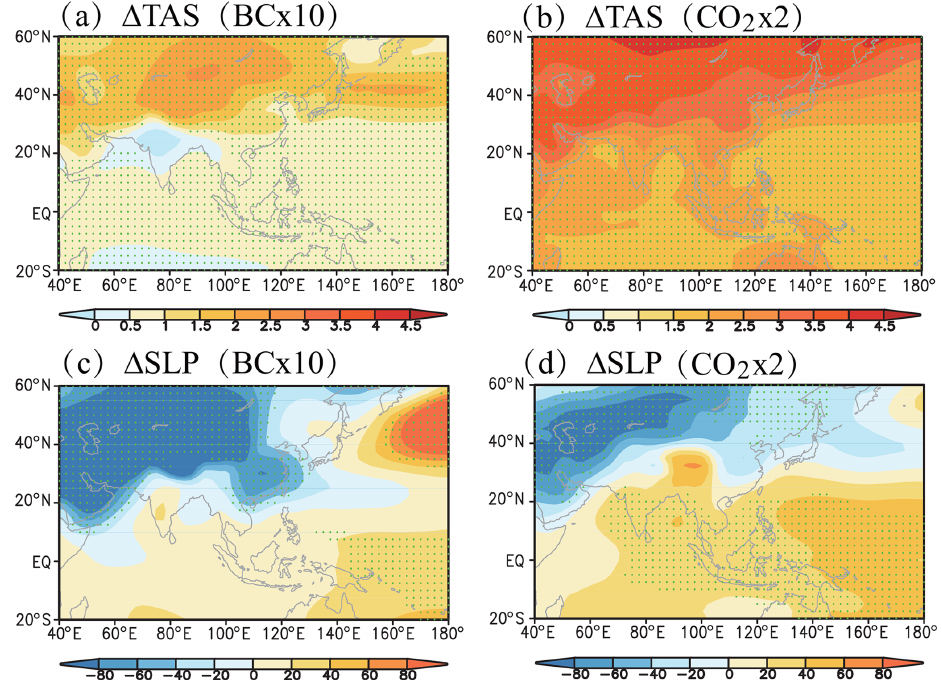
Figure 9. Changes in (a, b) multimodel mean (MMM) of the MJJAS surface atmospheric temperature ( (cid:49) TAS; unit: ◦ C) and (c, d) sea level pressure ( (cid:49) SLP; unit: hPa) under increasing BC and GHGs. Dotted regions indicate where the MMM is more than 1 standard deviation away from